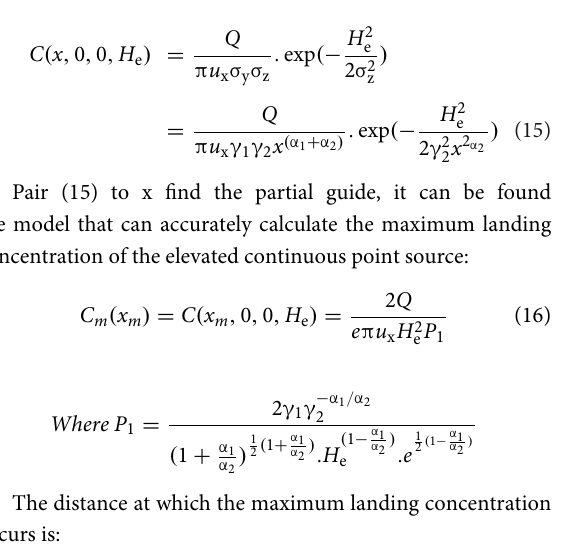
according to different levels of atmospheric